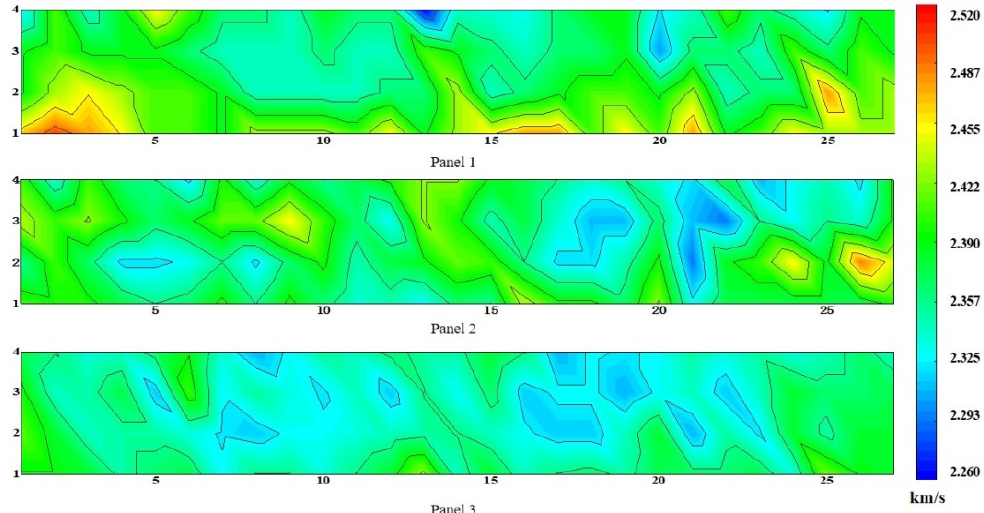
Figure 6. Ultrasonic pulse velocity distribution nephogram.